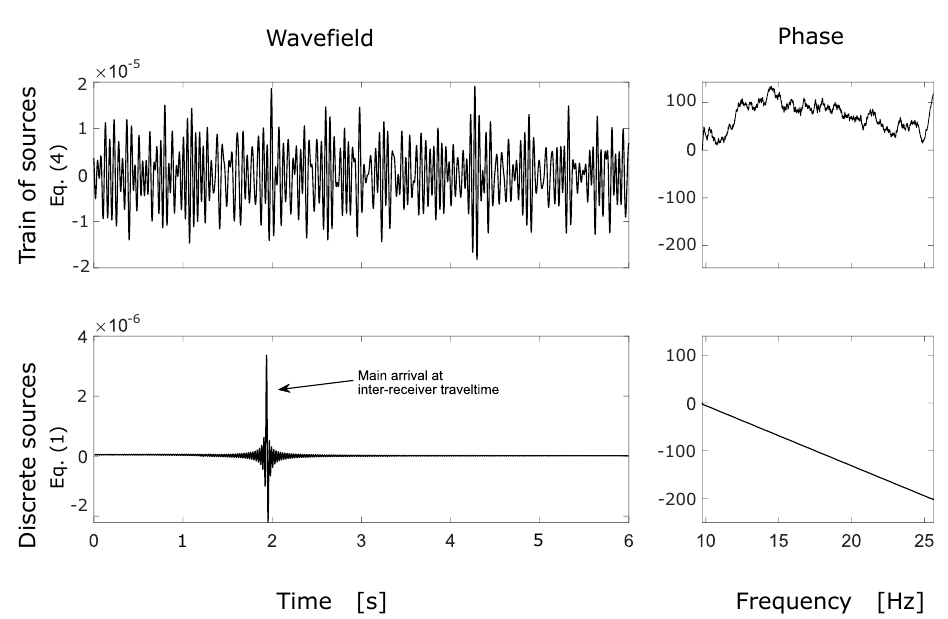
Figure 2. Comparison of the interferometric estimate of the Green’s function from a simulated train of sources as per Equation (4) ( top ), versus the estimate from a boundary of static point sources ( bottom ) recorded individually, according to Equation (1). The left side panels show the waveforms in time, while the panels to the right show the corresponding estimated phases (unwrapped). The source train moves along the boundary line at 25 m/s (90 km/h) and emits sound in a frequency range between 10 and 25 Hertz. The receiver pair is oriented perpendicularly to the source boundary and 2000 m away from each other. Sound speed in the medium was set at 1000 m/s. The receiver closest to the source boundary was 400 m